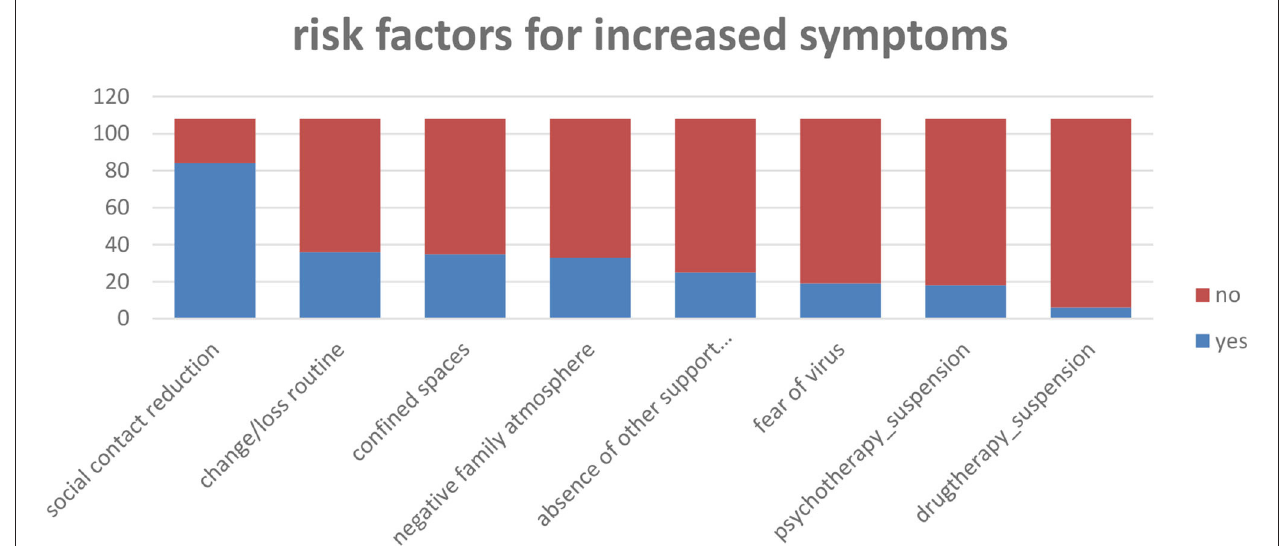
FIGURE 4 | Q.22. What factors do you think interfere negatively with symptom control in this period?